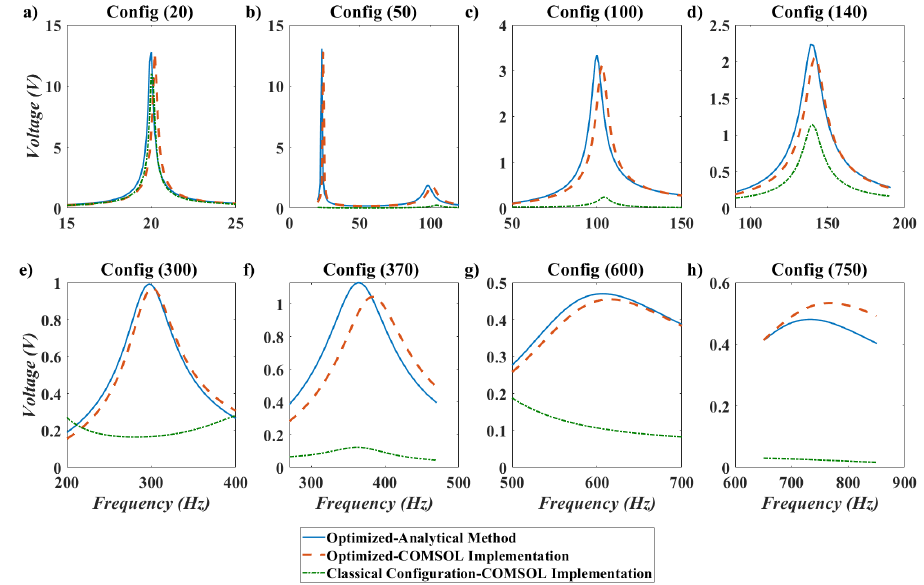
Figure 11. Frequency response for different configurations mentioned in Table